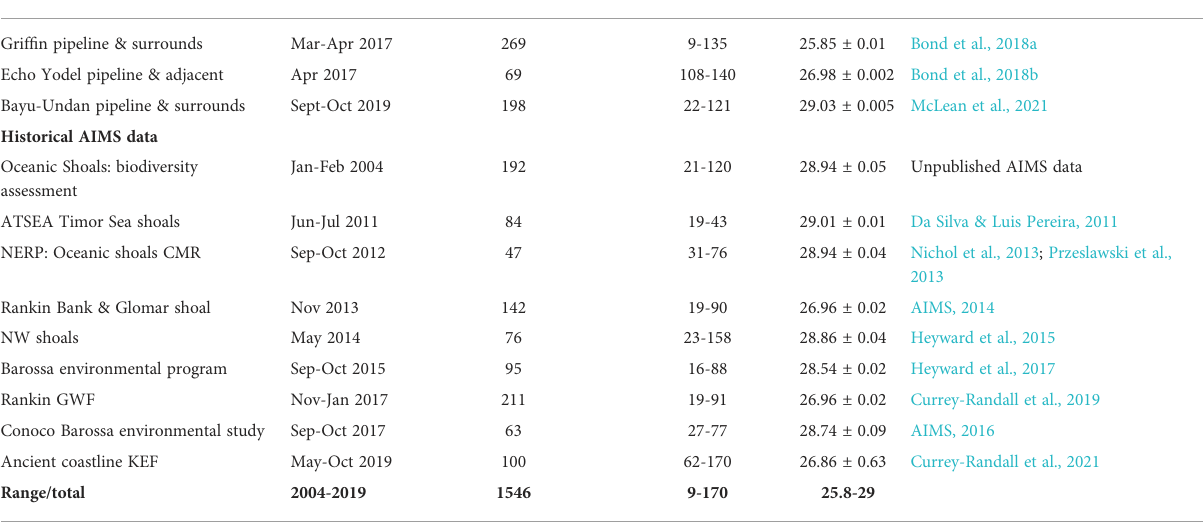
TABLE 1 A description of BRUVs data used and its